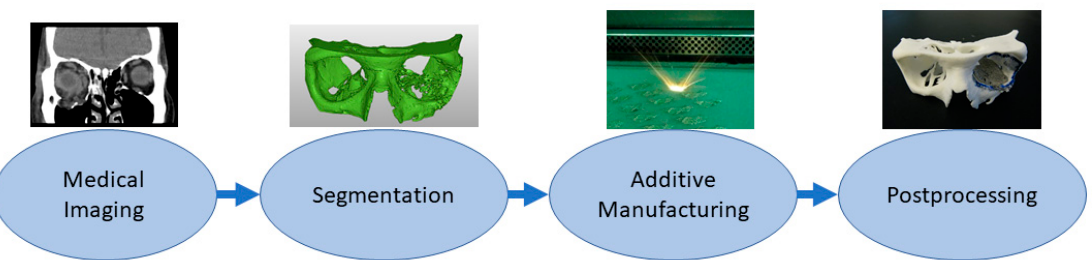
Figure 2. Typical process flow for medical models.